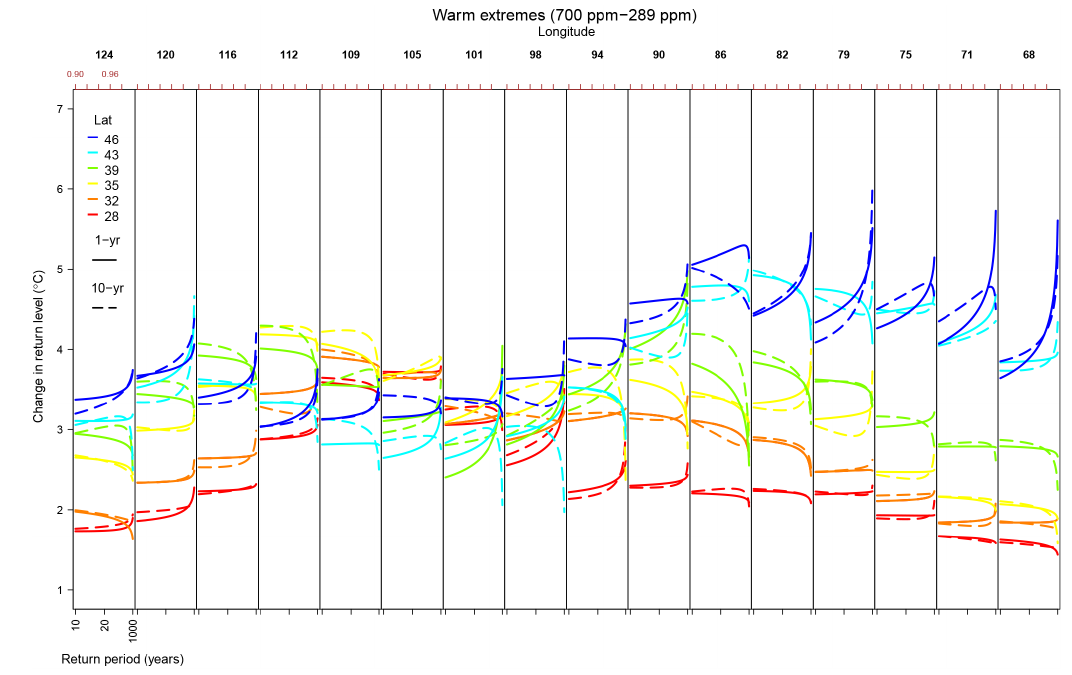
Figure C3. As in Fig. 7 (upper panel) but here comparing the estimated changes obtained from using annual maxima (solid lines) vs. decadal maxima (dashed lines). The results imply that annual blocks may be long enough to study the changes in warm extremes, since changes in return levels are fairly consistent with those using block sizes of 10 years.